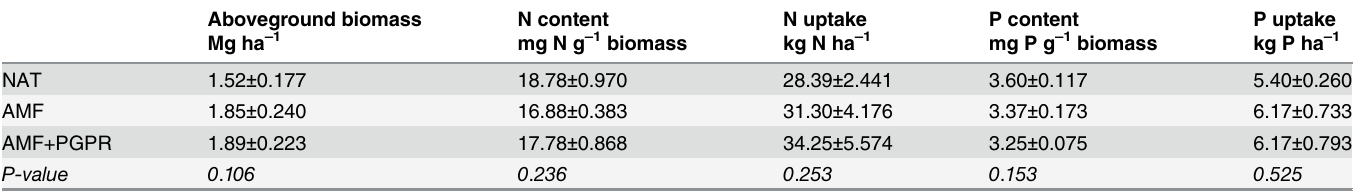
Table 1. Aboveground biomass, its N and P and root infection by AM fungi at tillering of durum wheat grown in the field. Aboveground